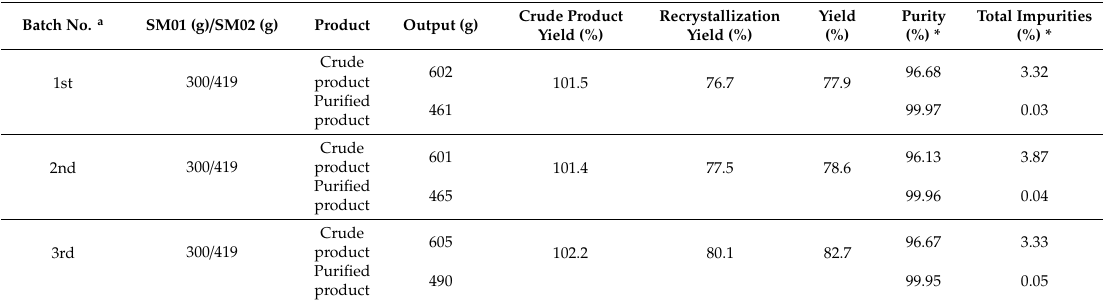
Table 7. Process validation of intermediate LM49-01 .